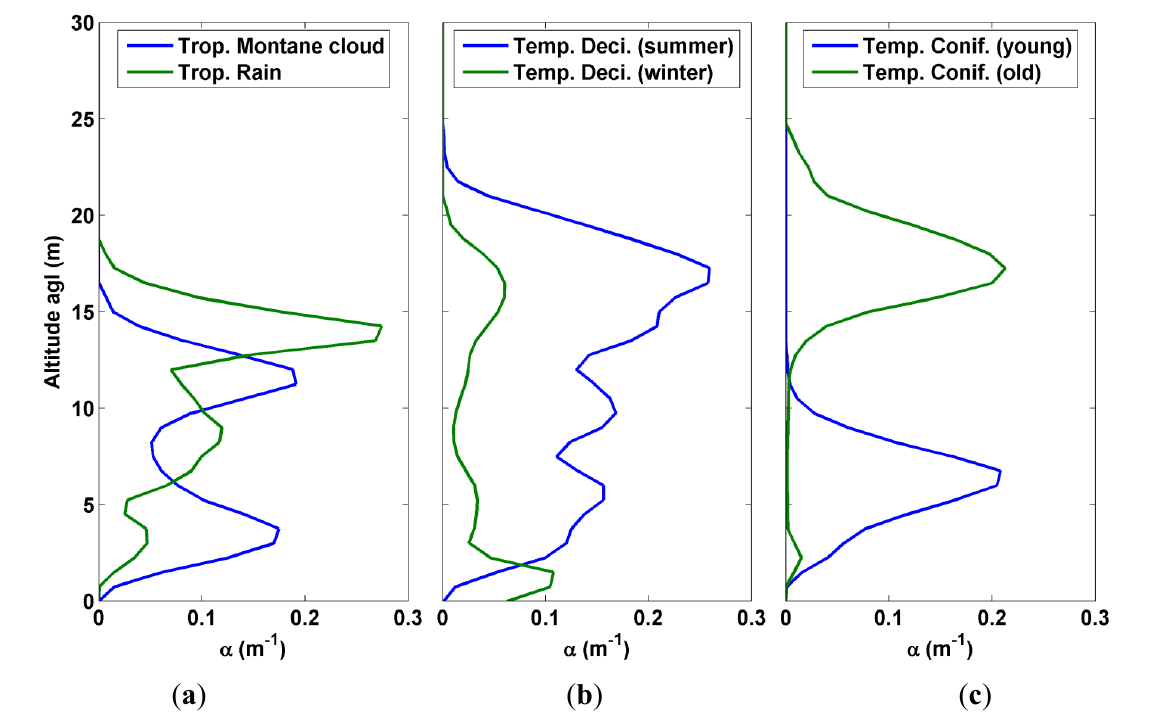
Figure 4. Examples of extinction coefficient profiles of 6 selected lidar profiles: ( a ) tropical montane cloud and rain forest; ( b ) temperate deciduous forest in both summer and winter, and ( c ) temperate conifer forest with young (10 years old) and old trees (50 years old). The tropical montane forest represents an approximate average of the measured biomes (Figure 3).